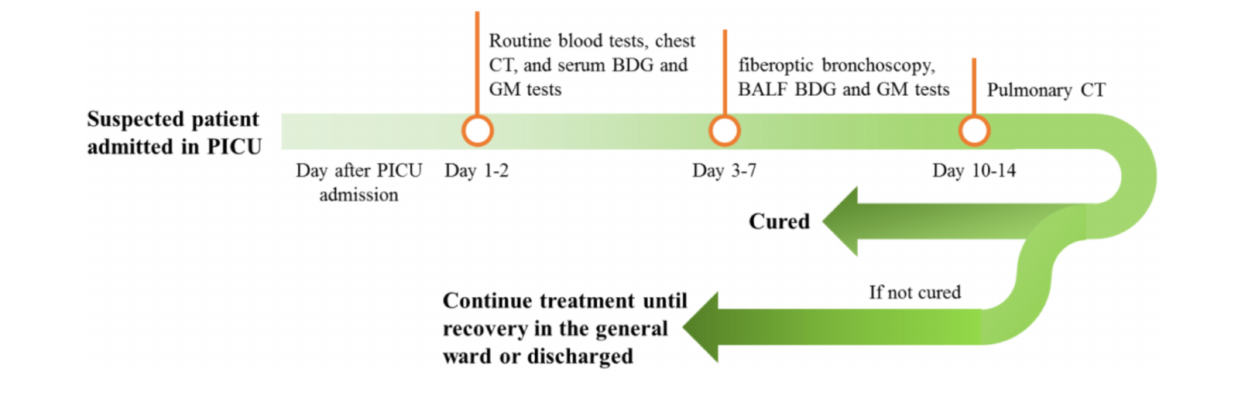
BALF samples using the dynamic turbidimetric method (fungal dextran detection kit). All tests were conducted following the manufacturer’s